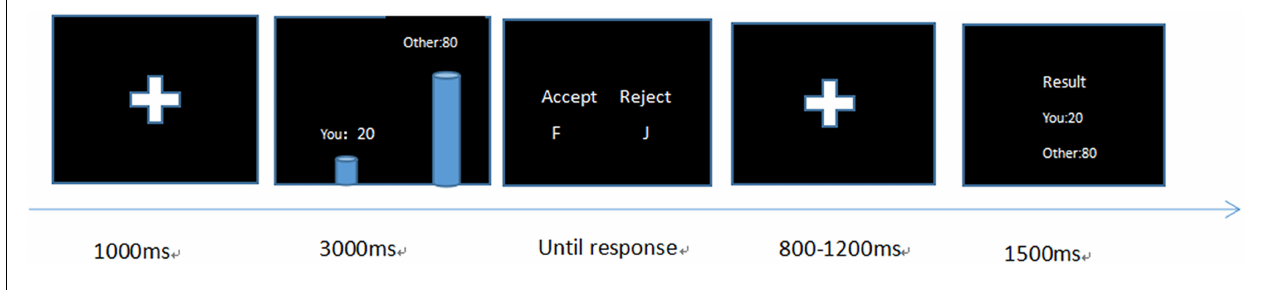
FIGURE 1 | Procedures of the ultimatum game (UG)